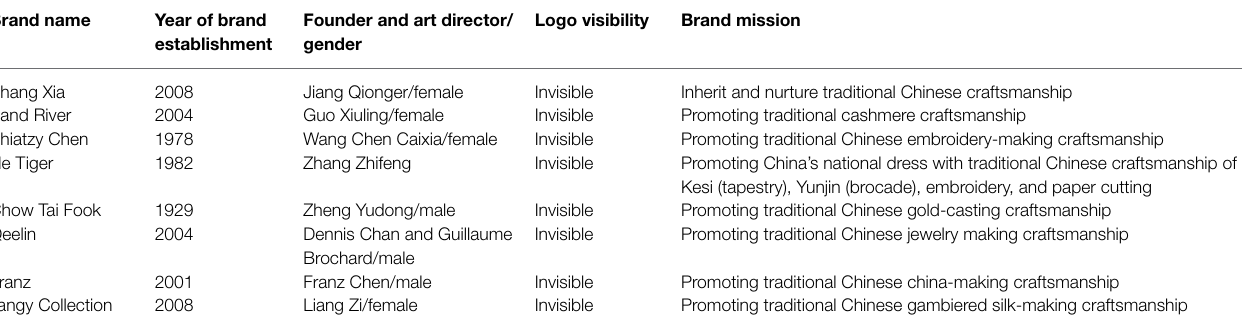
TABLE 2 | Profiles of Chinese luxury brands considered in this